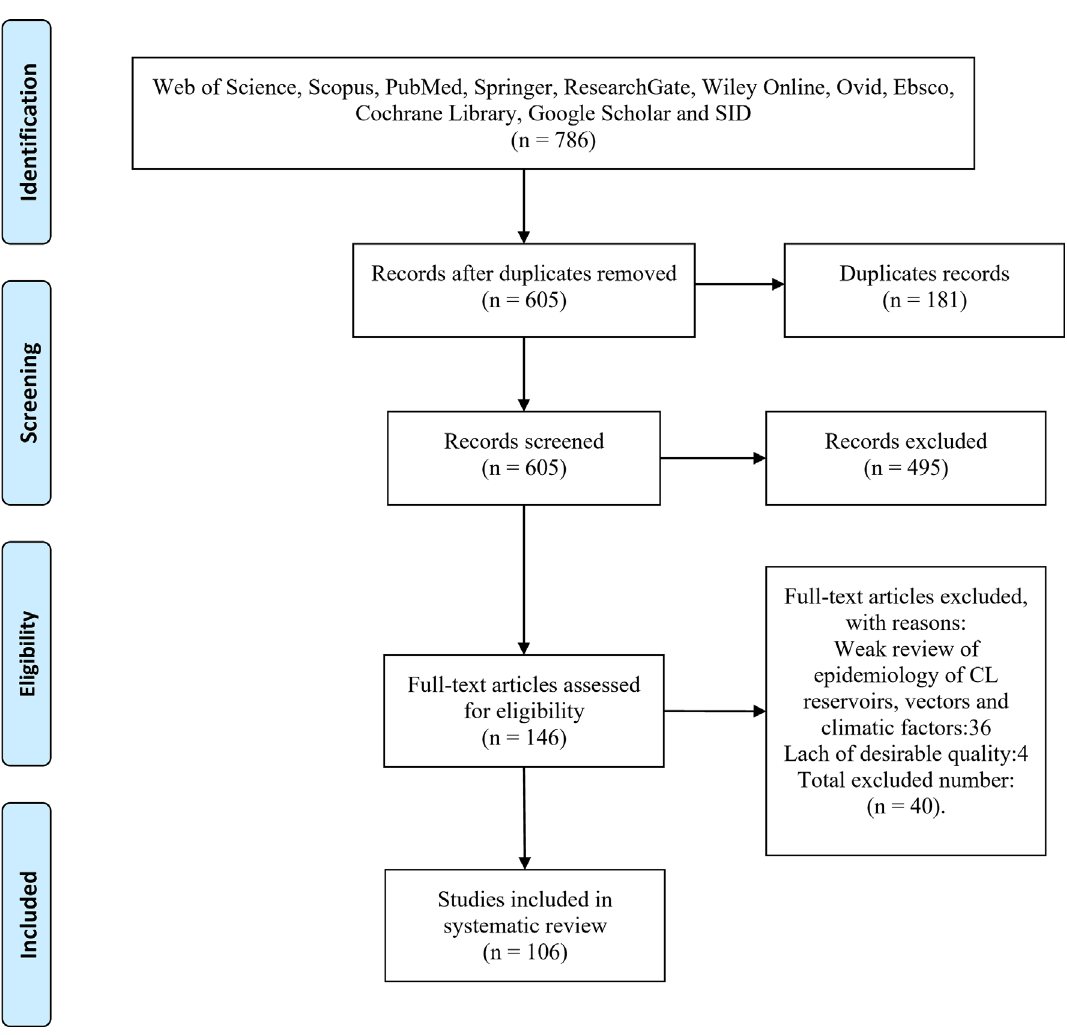
Fig. 1. The PRISMA fl ow